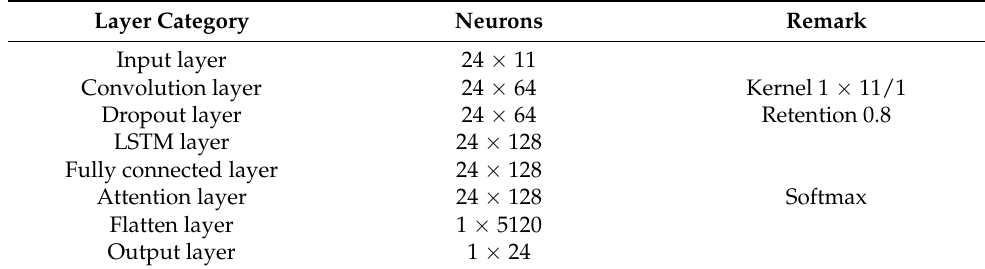
Table 4. The structure parameters of the